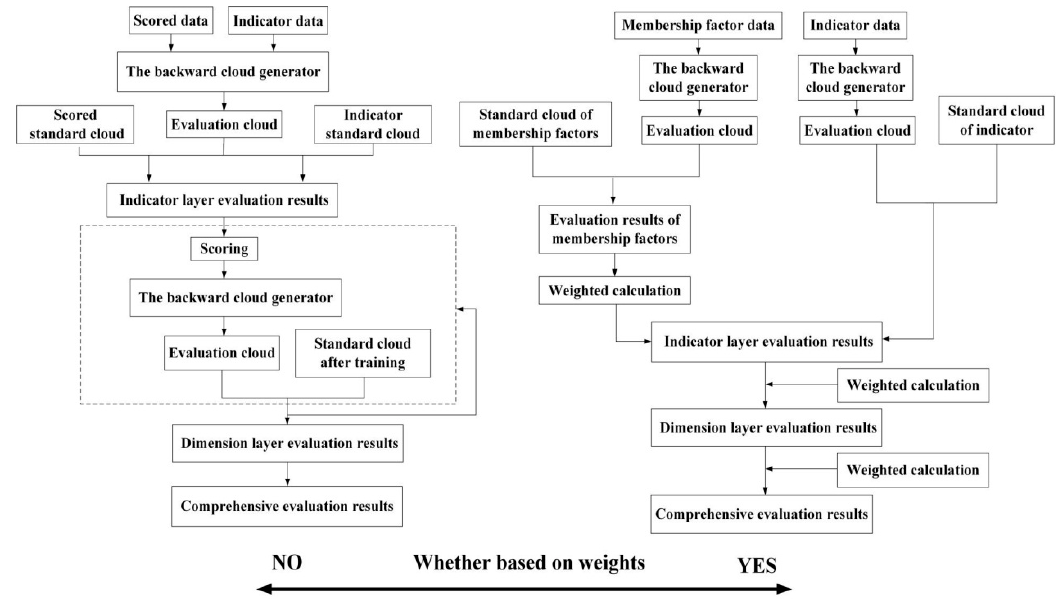
Figure 5. Evaluation mechanisms for the unweighted and weighted cloud models.